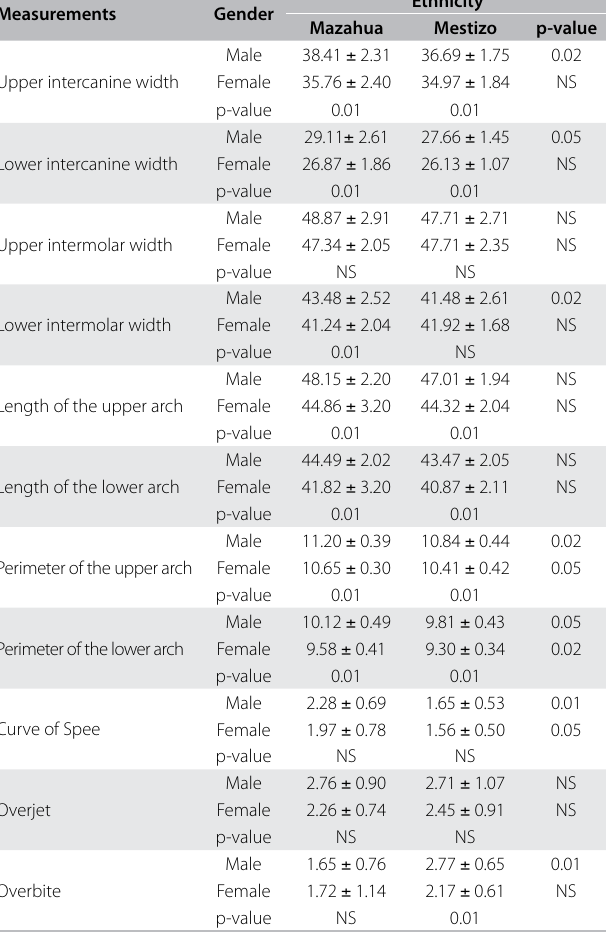
Data shown as mean ± SD; Based on Student’s t-test; NS: non significant; n=20 per group.